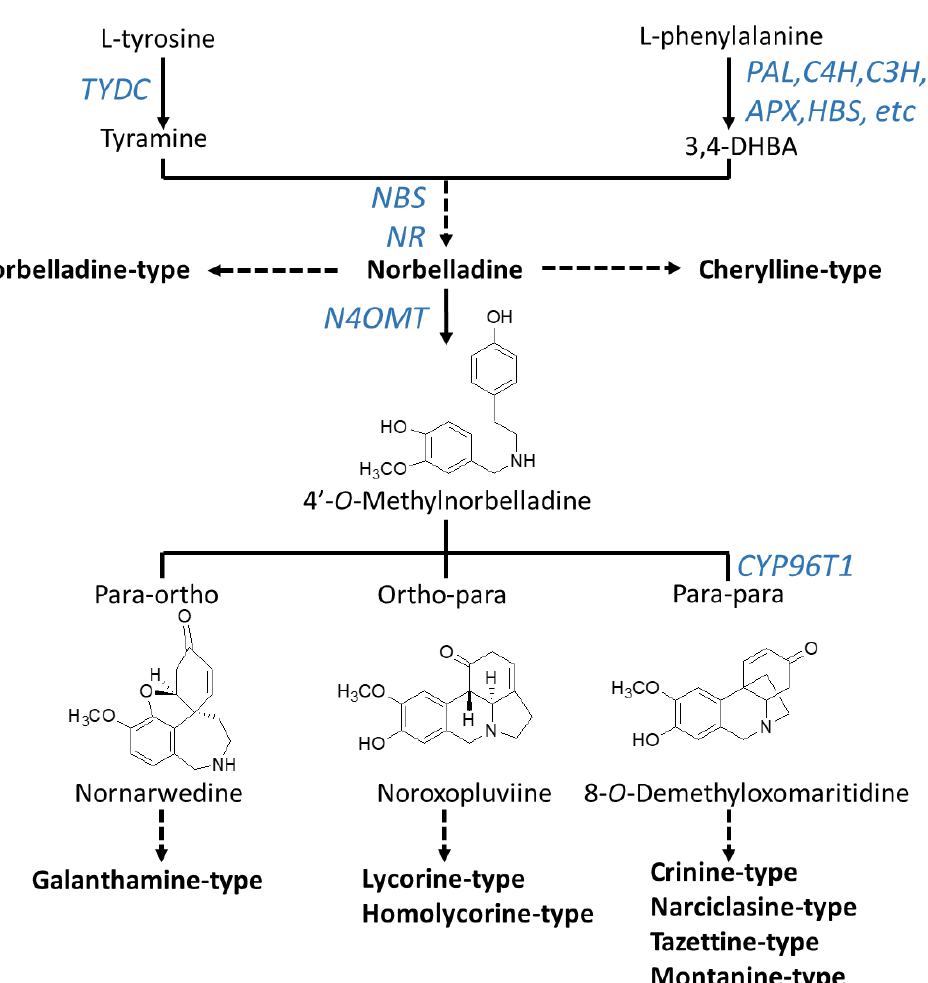
Figure 2. Biosynthesis pathway to major types of Amaryllidaceae alkaloids. Arrows without labeling reflect chemical reactions that have not been enzymatically characterized. Enzymes that have been identified are labeled in blue. A solid arrow symbolizes one enzymatic step whereas a broken arrow shows multiple enzymatic reactions. Chemical structures of precursors were added to clarify the regioselective phenol-phenol’ coupling reaction. Enzyme abbreviations: PAL, phenylalanine ammonia-lyase; C4H, cinnamate 4-hydroxylase; C3H, coumarate 3-hydroxylase; APX, ascorbate peroxidase; HBS, 4-hydroxybenzaldehyde synthase; TYDC, tyrosine decarboxylase; NBS, norbelladine synthase; NR, noroxomaritidine reductase; CYP96T1, cytochrome P450 monooxygenase 96T1.